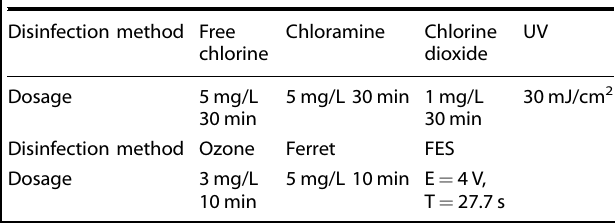
Fig. 7 The relationship between normalised fl ux drop and relative abundance of typical highly secretory. a Accumulative relative abundance of typical highly secretory or biofouling-related genera reported by previous research and b its correlation with normalised fl ux drop of RO membranes. The correlation coef fi cient and p value were generated by Pearson correlation analysis (R 2 = 0.64, p < Table 2. Dosage of each disinfection method.